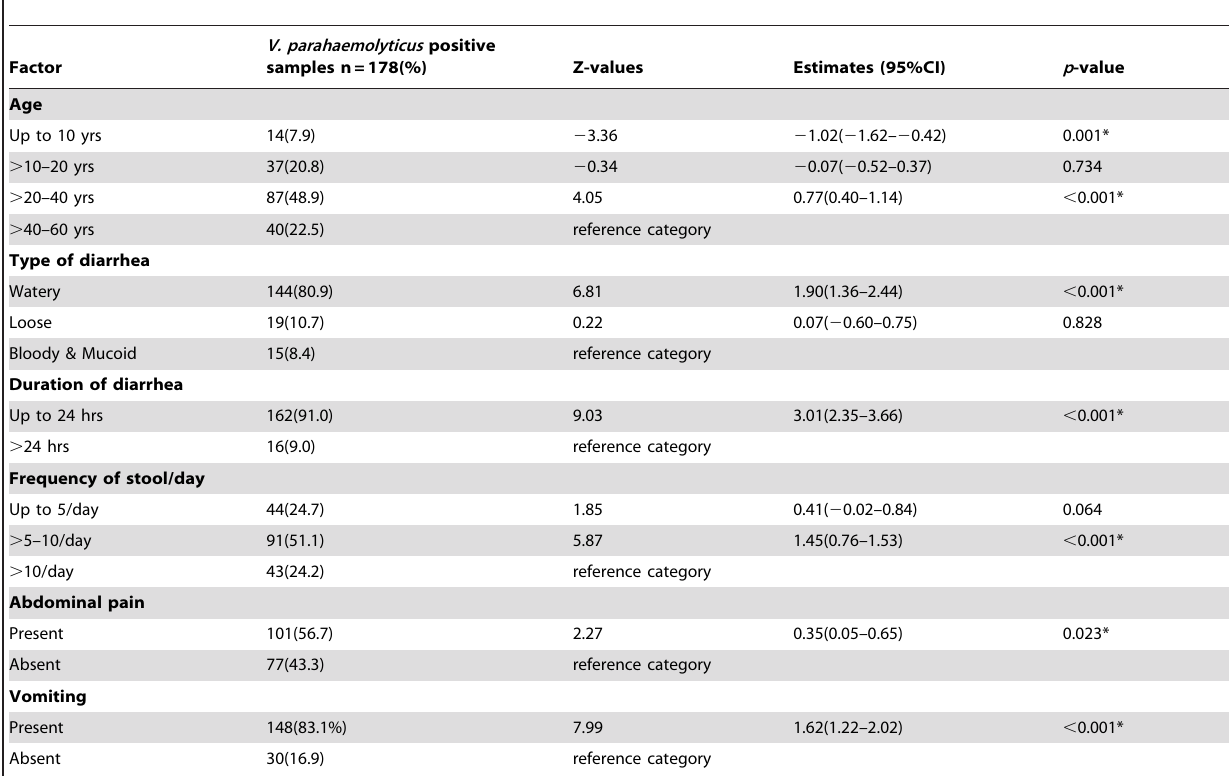
Table 4. General log-linear model analysis of clinical factors with V. parahaemolyticus